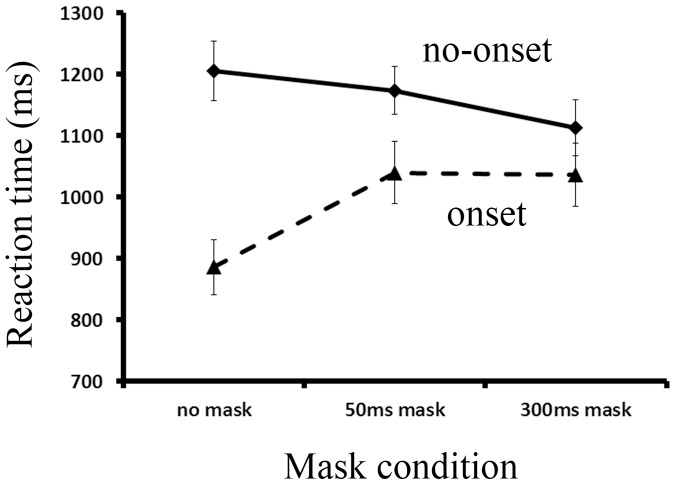
The mean reaction time of all conditions in Experiment 1.The error bar is one standard error.